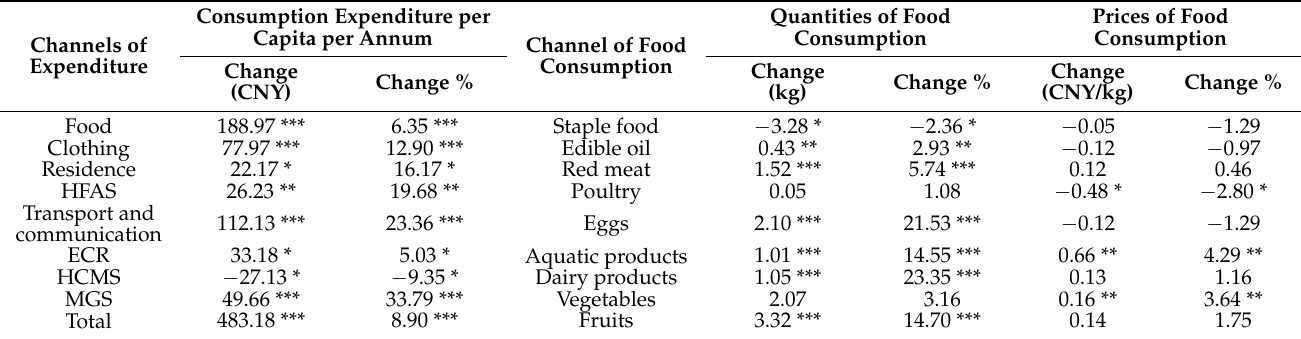
Table 5. The channels through which internet access affects nutritional